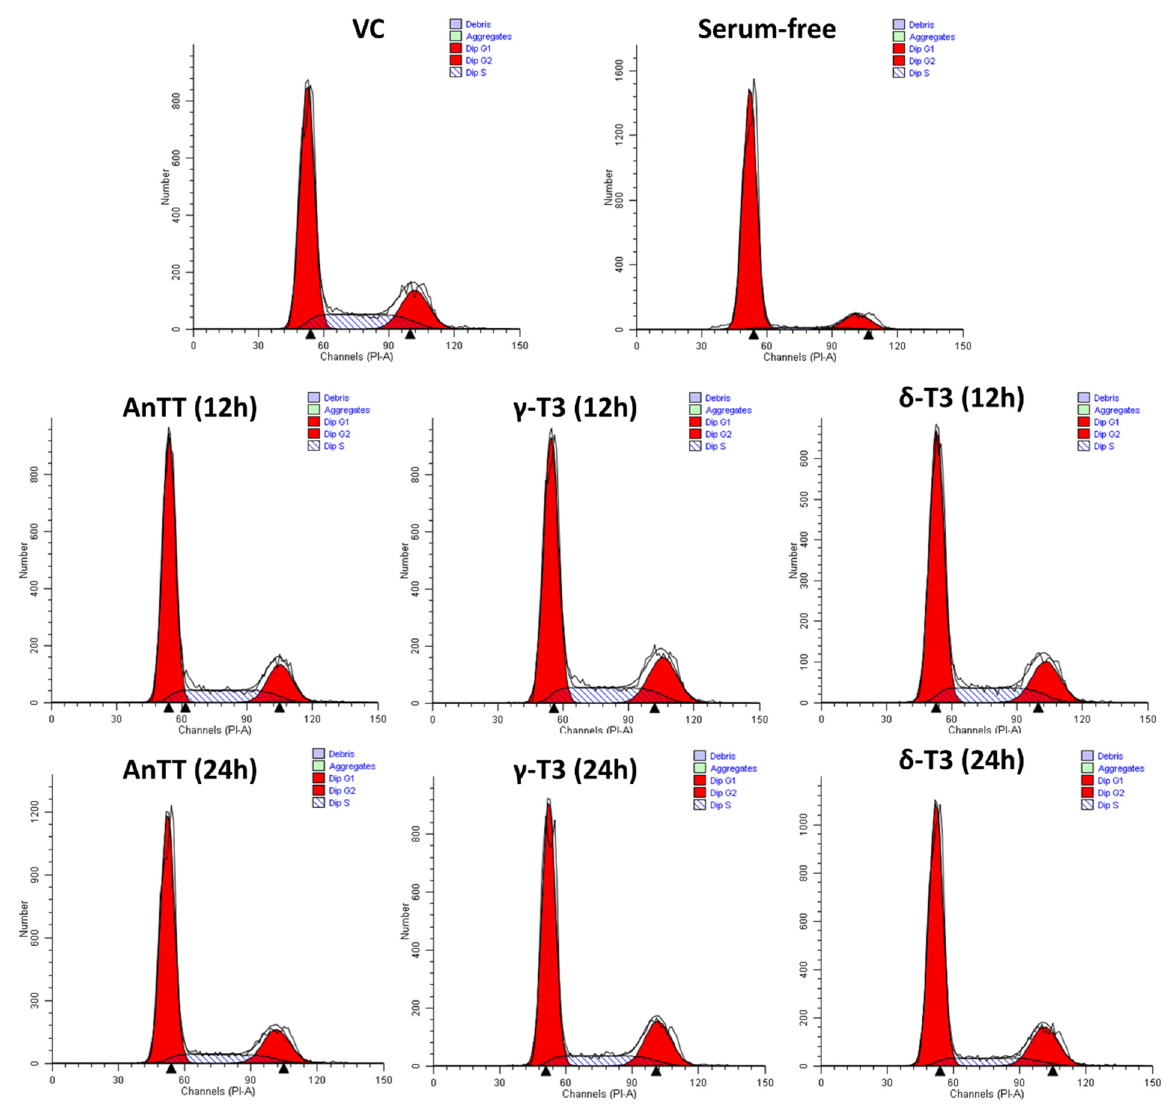
Figure 6. The representative cell cycle distribution analysis from the ModFit LT software. Abbrevia- tions: AnTT, annatto tocotrienol; δ -T3, δ -tocotrienol; γ -T3, γ -tocotrienol; VC, vehicle control.